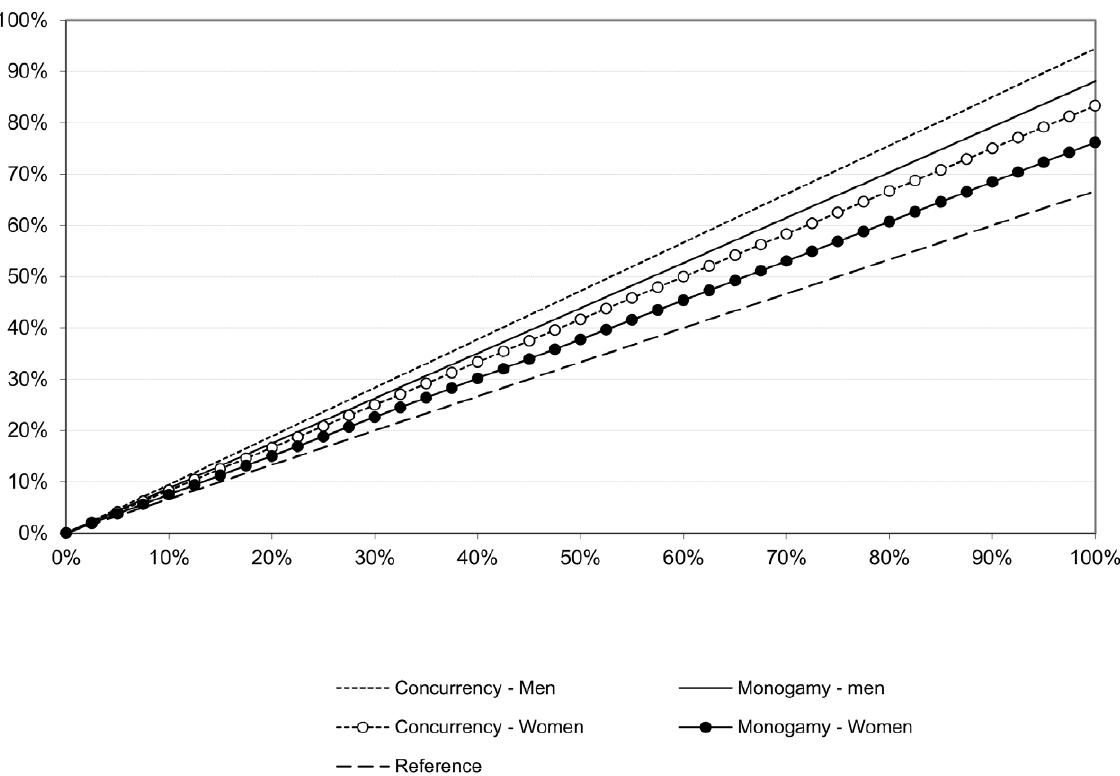
Figure 2. Relative Percentage decline in new HIV infections by HTC coverage and scenario.